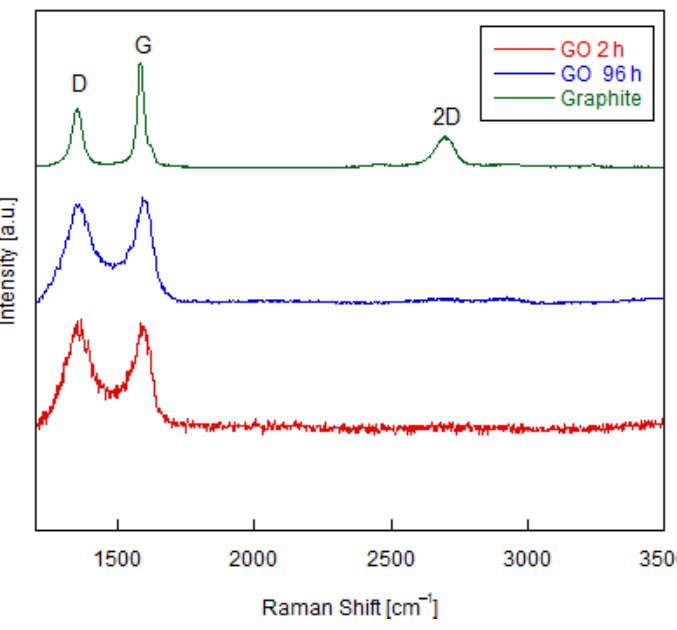
Figure 3. Raman spectrum of Graphite, GO 2 h and GO 96 h.